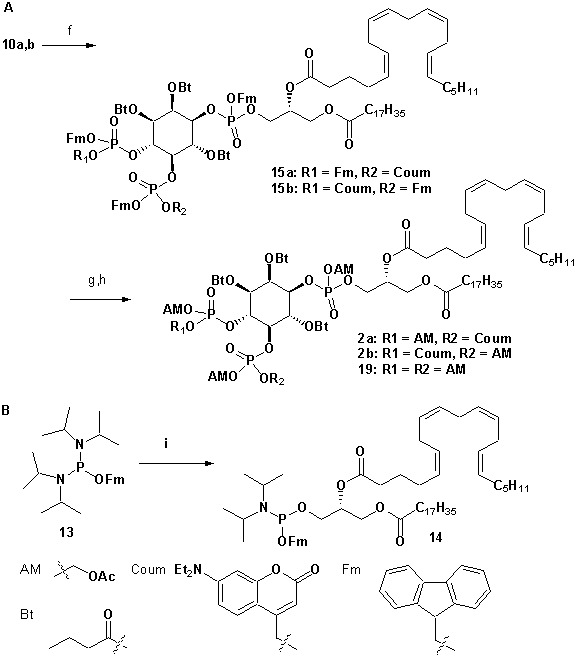
Synthesis of 2a,b.